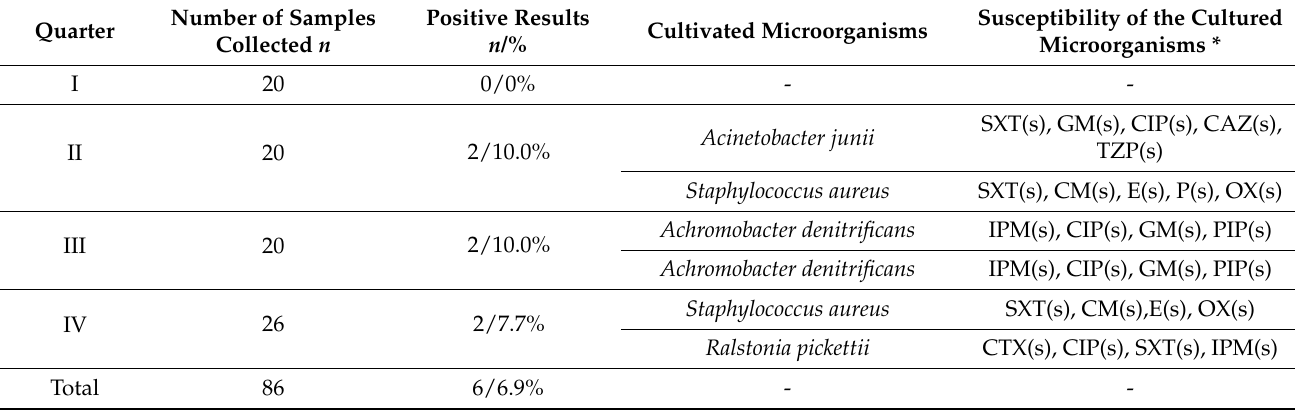
Table 1. Swabs taken from surfaces and equipment of an endoscopic examination laboratory in 2019 and cultured microorganisms.